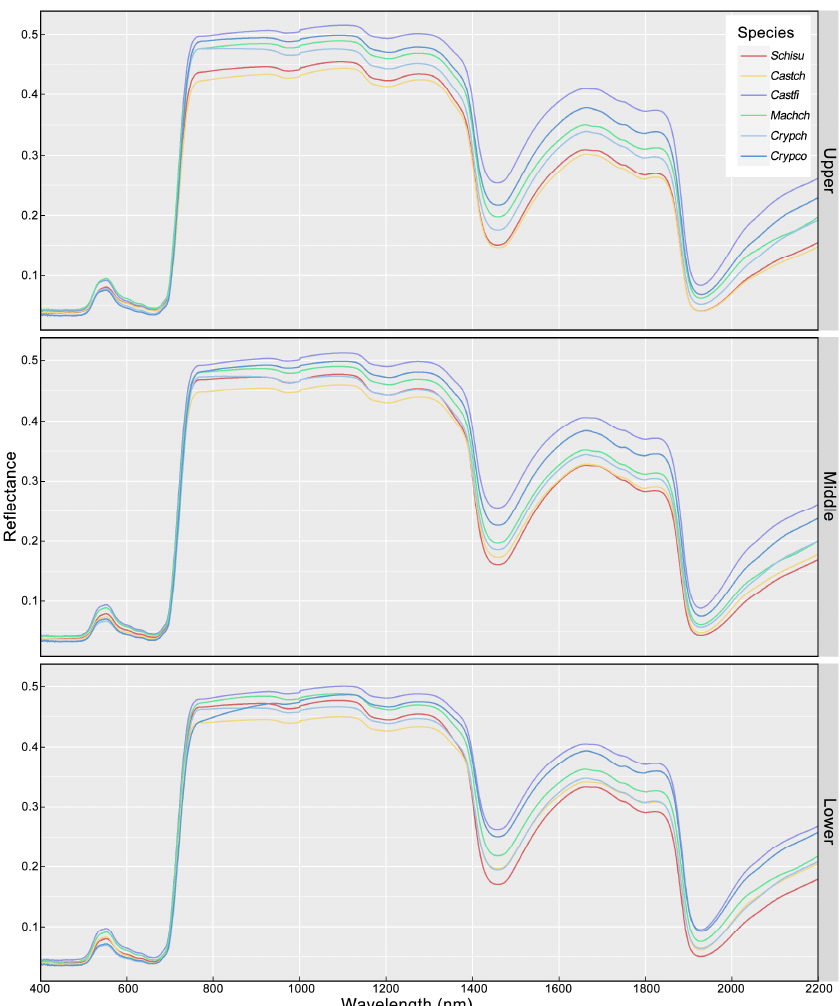
Figure 5. Variation of leaf hyperspectral reflectance in each tree species across three canopy layers.